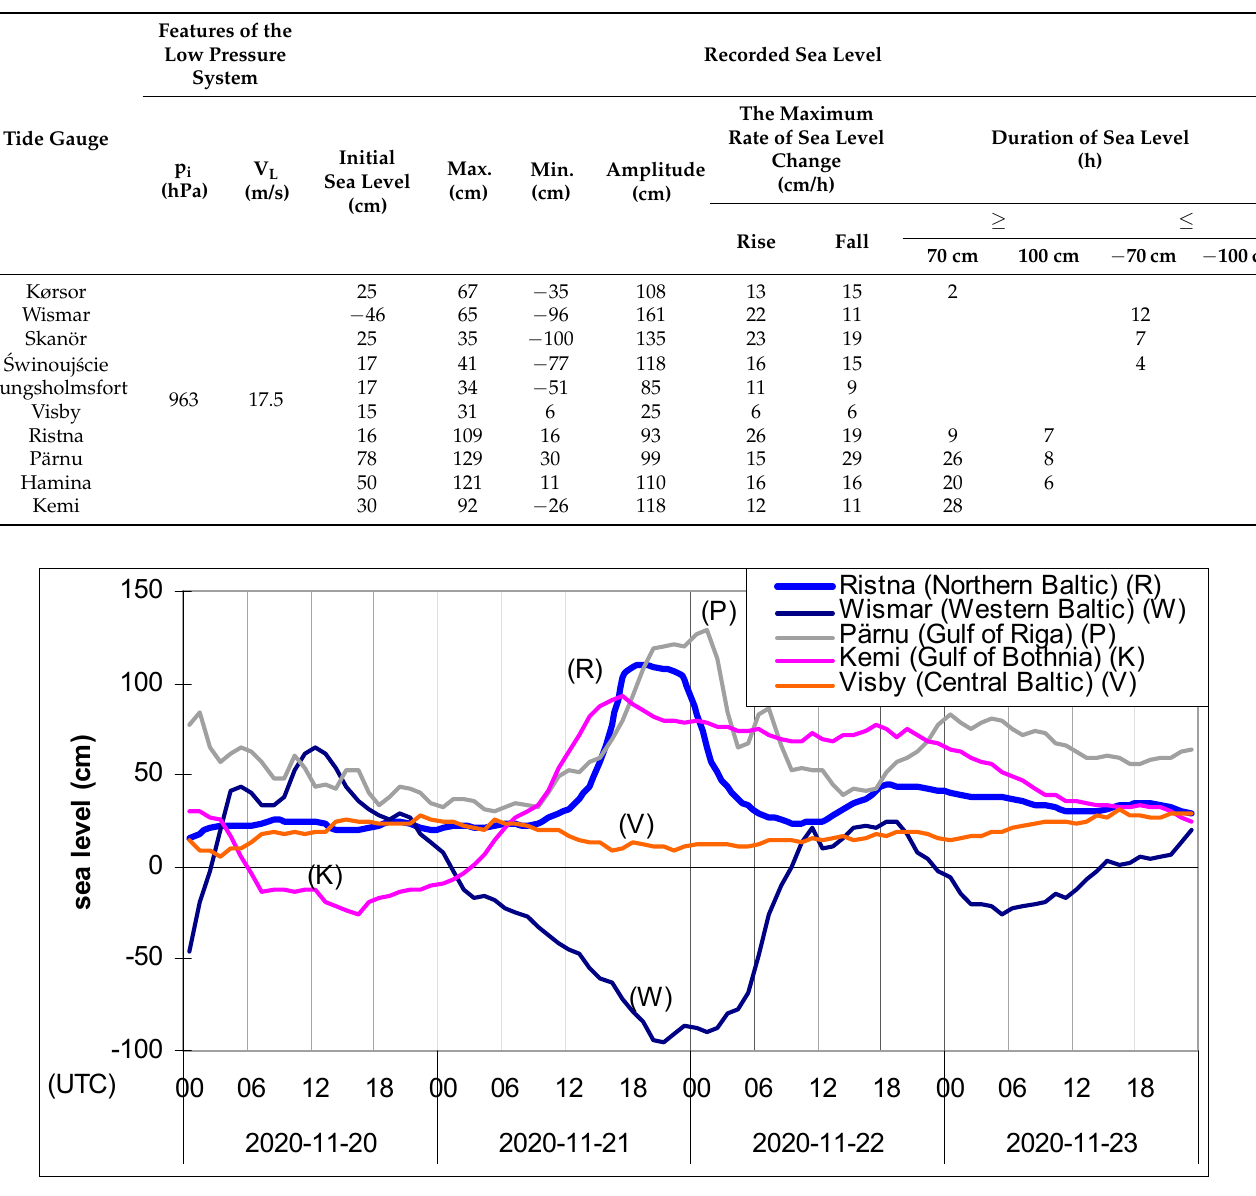
Figure 7. Sea level changes at representative stations in the main basins of the Baltic Sea from 20 to 23 November 2020. (Alternating, seiche-like sea level oscillations between the southwestern and northeastern Baltic